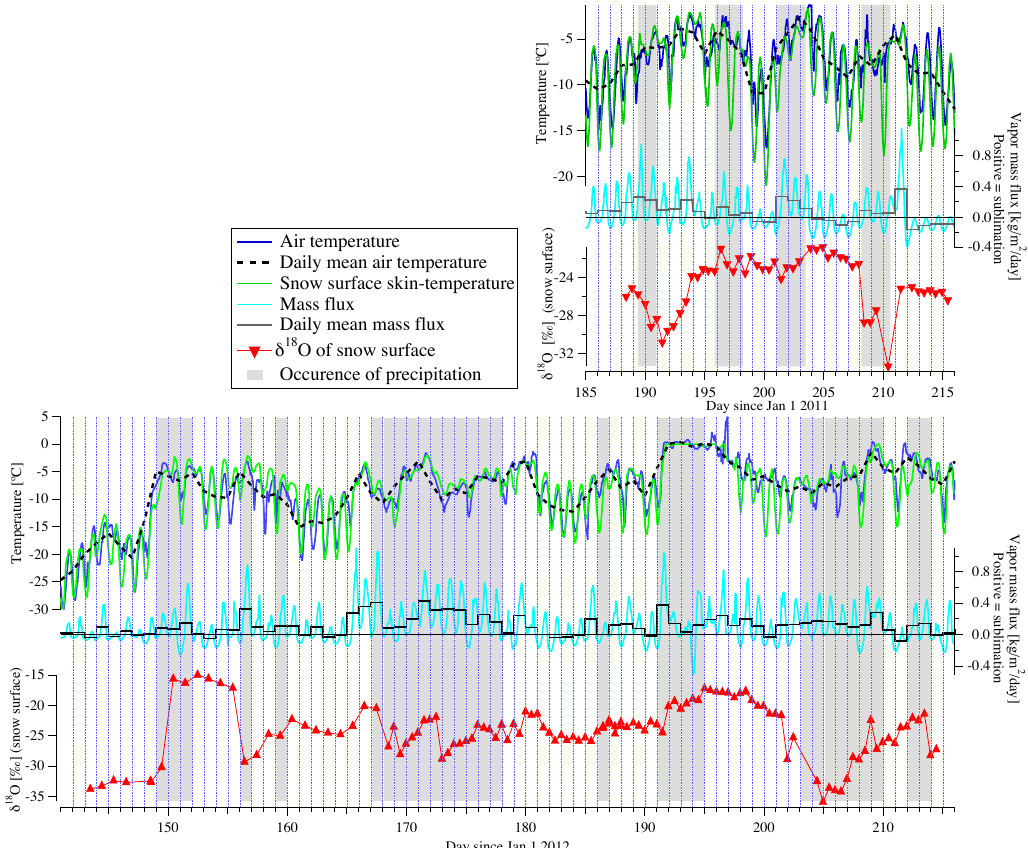
Fig. 5. Top and bottom panel show data from 2011 and 2012, respectively. The air temperature and snow surface skin temperature modeled by CROCUS are shown in blue and green, respectively (Daily mean air temperature shown in black). The estimated vapor mass flux from CROCUS with hourly resolution and daily mean values are shown in cyan and black, respectively. The variability in the surface snow δ 18 O s value is shown